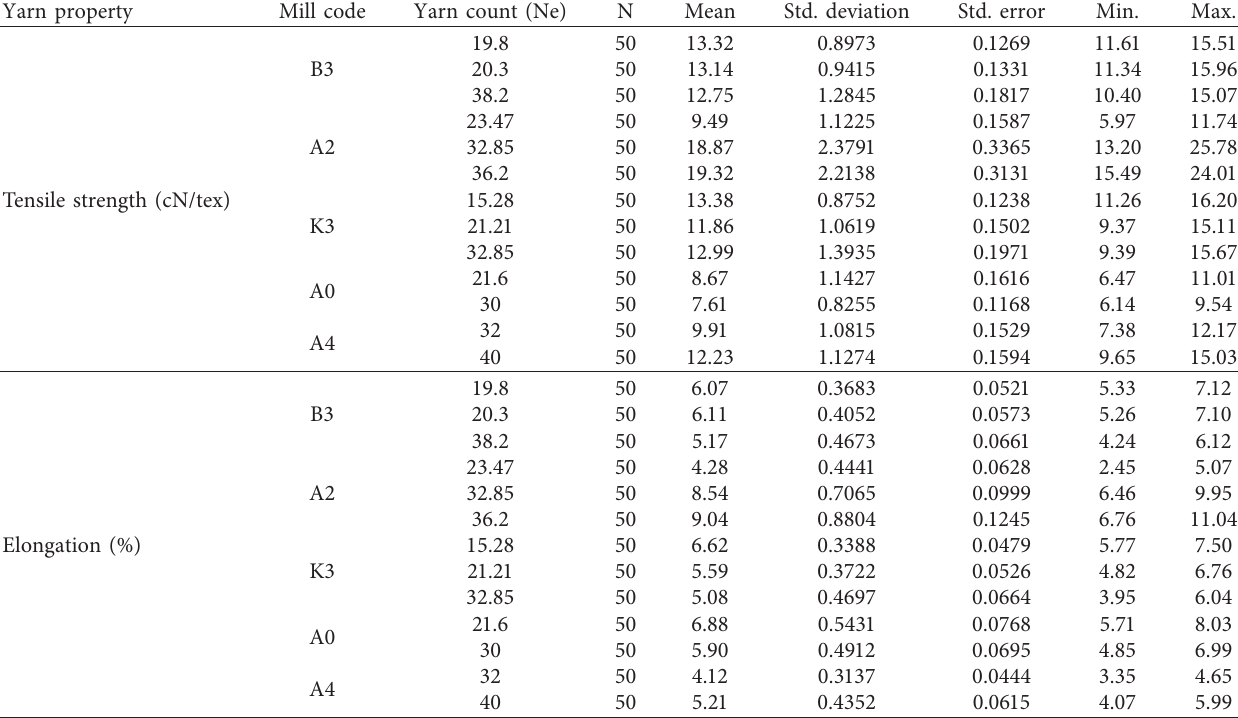
Table 6: Decretive analysis of yarn strength and